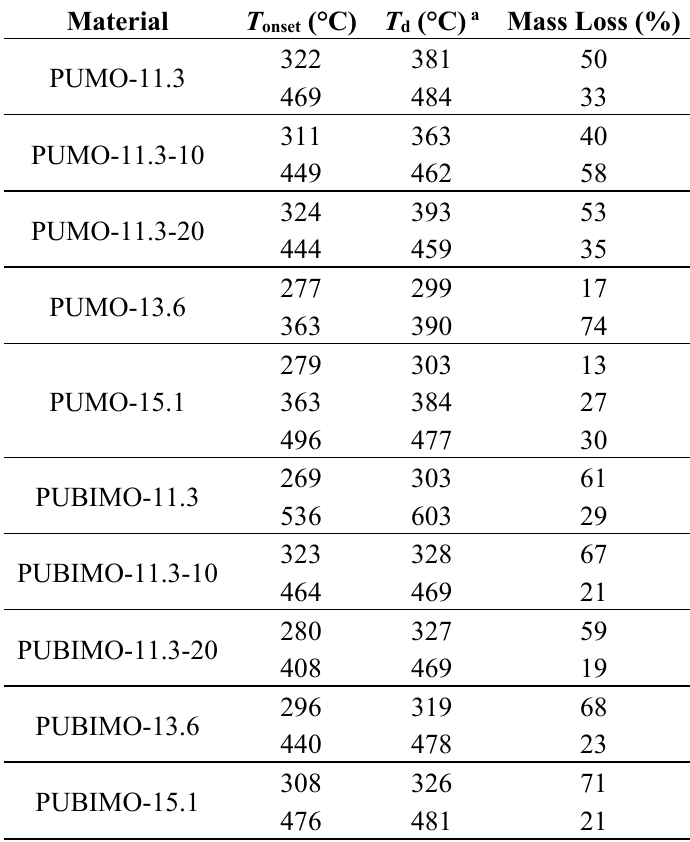
Figure 5. TG curves of PUBIMO-11.3, PUBIMO-13.6, PUBIMO-15.1, PUMO-11.3, PUMO-13.6, and PUMO-15.1, acquired at a heating rate of 10 °C·min − 1 . Table 2. T onset , T d , and mass loss of PUMO and PUBIMO in [NCO/OH] molar ratios of 11.3, 13.6, and 15.1; PUMO-11.3 and PUBIMO-11.3 with 10 wt % and 20 wt % of coconut husk